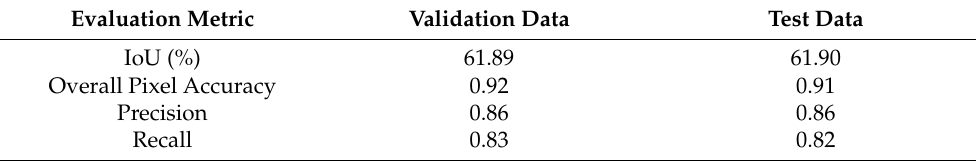
Table 2. Average building detection accuracy of the four cities from the modified U-Net model. Evaluation Metric